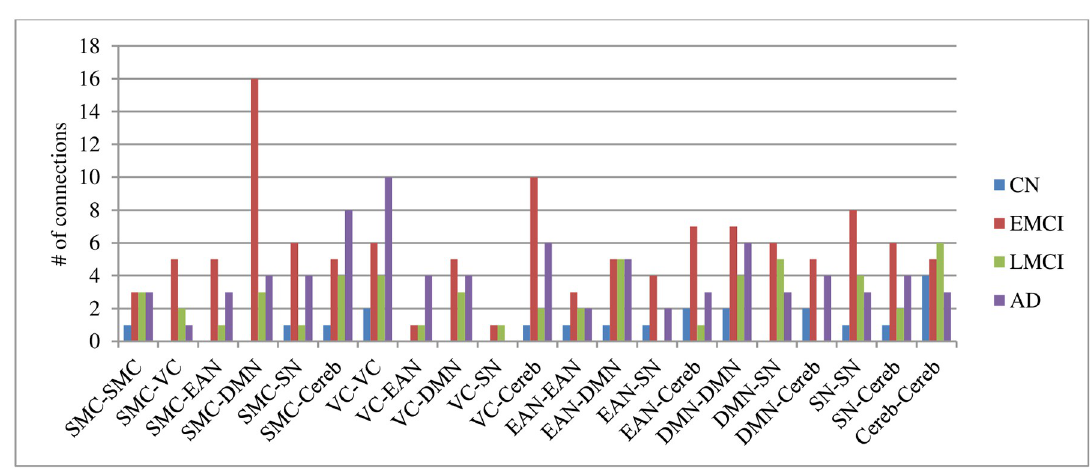
Fig 5. Number of connections with strength > 0.1 grouped by input-output networks with connection’s directionality ignored. Sensorimotor Cortex (SMC), Visual Cortex (VC), Executive Attention Network (EAN), Default-Mode Network (DMN), Subcortical Nuclei (SN), and Cerebellum